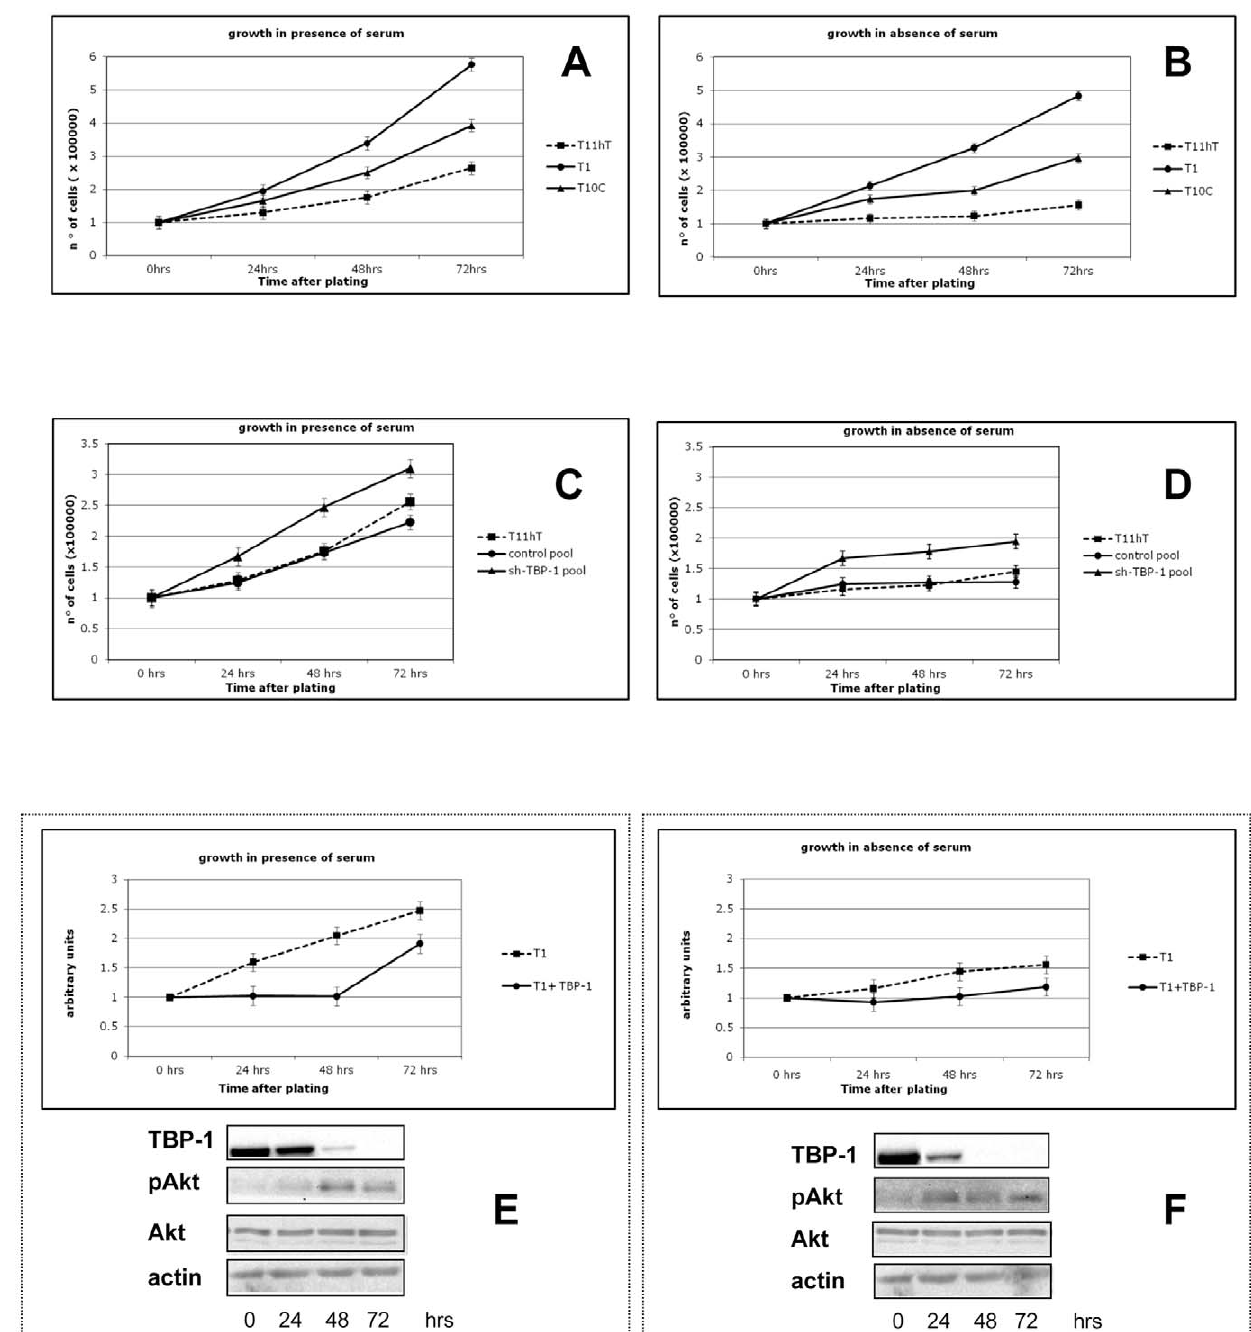
Figure 2. TBP-1 knockdown determines an increase in the growth properties. A, B: Cells from the T1, T10C and control cells (wt T11hT) were cultured in DMEM either in the presence ( A ) or in absence ( B ) of 10% FBS. Cells were collected at the time points indicated and counted in a Burker chamber. The values are the mean 6 SE of three experiments performed in triplicate. C, D : wt T11hT cells, cells from control cell pool or from the sh -TBP-1 cell pool were cultured in DMEM either in the presence ( C ) or in absence ( D ) of 10% FBS. Cells were collected at the time points indicated and counted in a Burker chamber. The values are the mean 6 SE of three experiments performed in triplicate. E, F: Cells from the T1 clone were transfected by electroporation with empty vector (indicated just as T1) or TBP-1 expression plasmid (indicated as T1 + TBP-1); cells were then cultured either in the presence ( E ) or in absence ( F ) of 10%FBS and collected at the time points indicated (being T 0 the time at 24 hours after transfection). Cells from each time point have been counted in a Burker chamber. Values are mean 6 SE of two experiments performed in triplicate and are indicated as values relative to the reference point (T 0 ). E, F lower panels : TBP-1 expression and Akt activation have been evaluated by Western Blot with anti-TBP-1, anti-Phospho-Akt Ser473, anti-Akt and anti-actin, as loading control, on whole protein lysates of cells collected at each time point, as indicated.